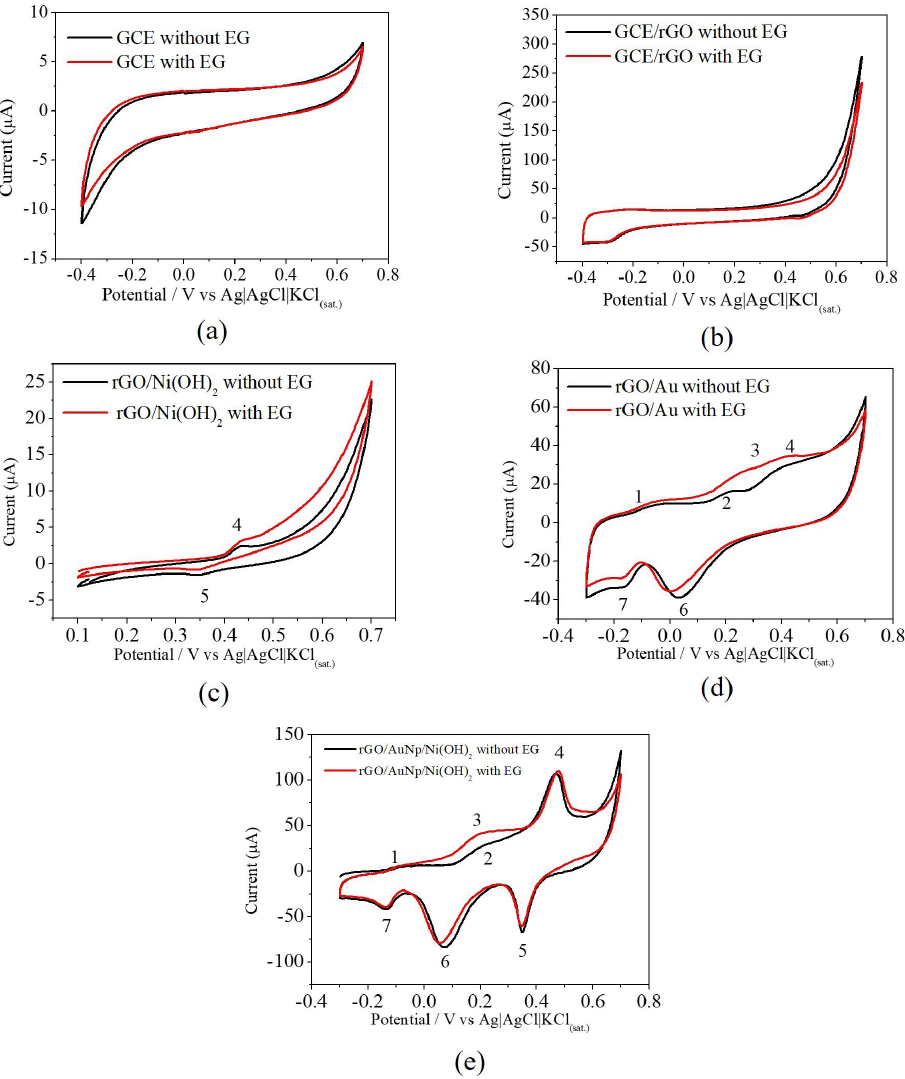
/rGO/GCE (c), AuNp/rGO/GCE (d) and Ni(OH) /AuNp/rGO/GCE 2 2